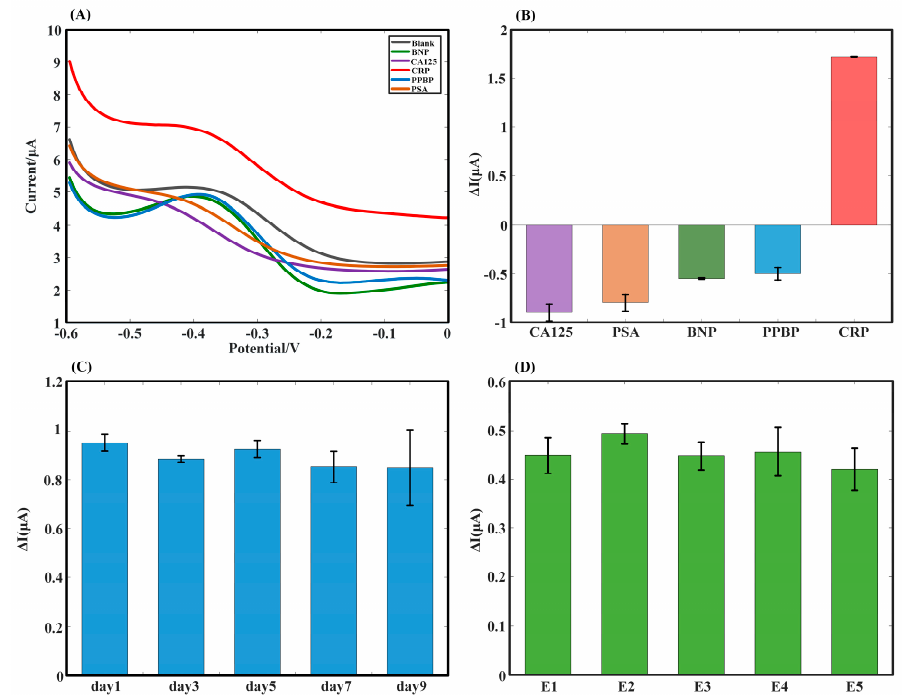
Figure 4. Selectivity, stability, and reproducibility tests based on the SPE/AuNPs/GO-COOH aptamer sensor. ( A ) Voltage-current plot of CRP vs. interfering solutions using the DPV method. Red: 1 ng/mL CRP; black: PBS solution; blue: 1 ng/mL PPBP; green: 1 ng/mL BNP; orange: 1 ng/mL PSA; purple: 1 ng/mL CA125. ( B ) The plot of the selectivity error analysis corresponds to ( A ) (n = 3). ( C ) Error analysis plots were obtained by selecting the electrodes on day 1, day 3, day 5, day 7, and day 9 for testing against 1 ng/mL CRP solution (n = 3). ( D ) Reproducibility test plots of five aptamer-sensing electrodes for multiple assays of 0.001 ng/mL CRP(n - 3).